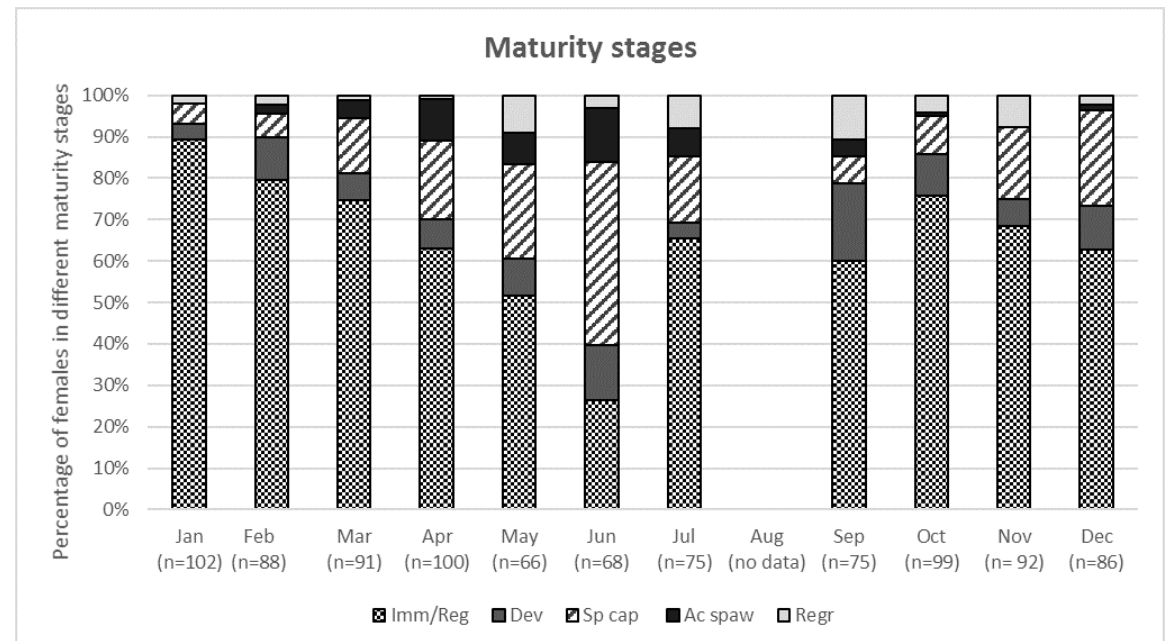
Figure 1. Monthly percentages of European hake female maturity stages. Imm/reg, includes individuals in immature and regenerating stages; dev, developing; spaw, spawning capable; ac spaw, actively spawning, regr, regressing. For their histological characteristic, the immature and regenerating stages were grouped (See Section 3.2).